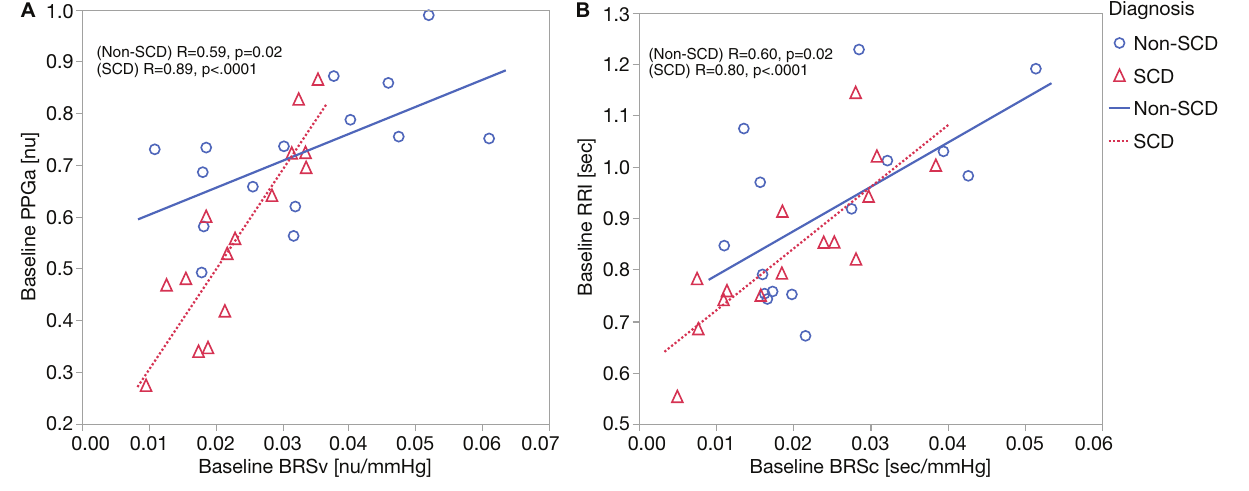
controls ( p = 0.01). Age, gender and hemoglobin were not related to the magnitude of the